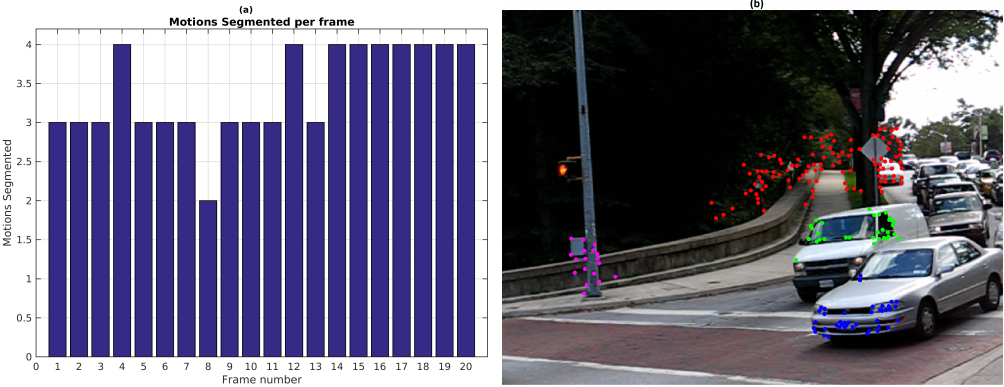
Figure 13. Baseline method results for Scene 4: ( a ) Number of motions by frame; ( b ) Motion